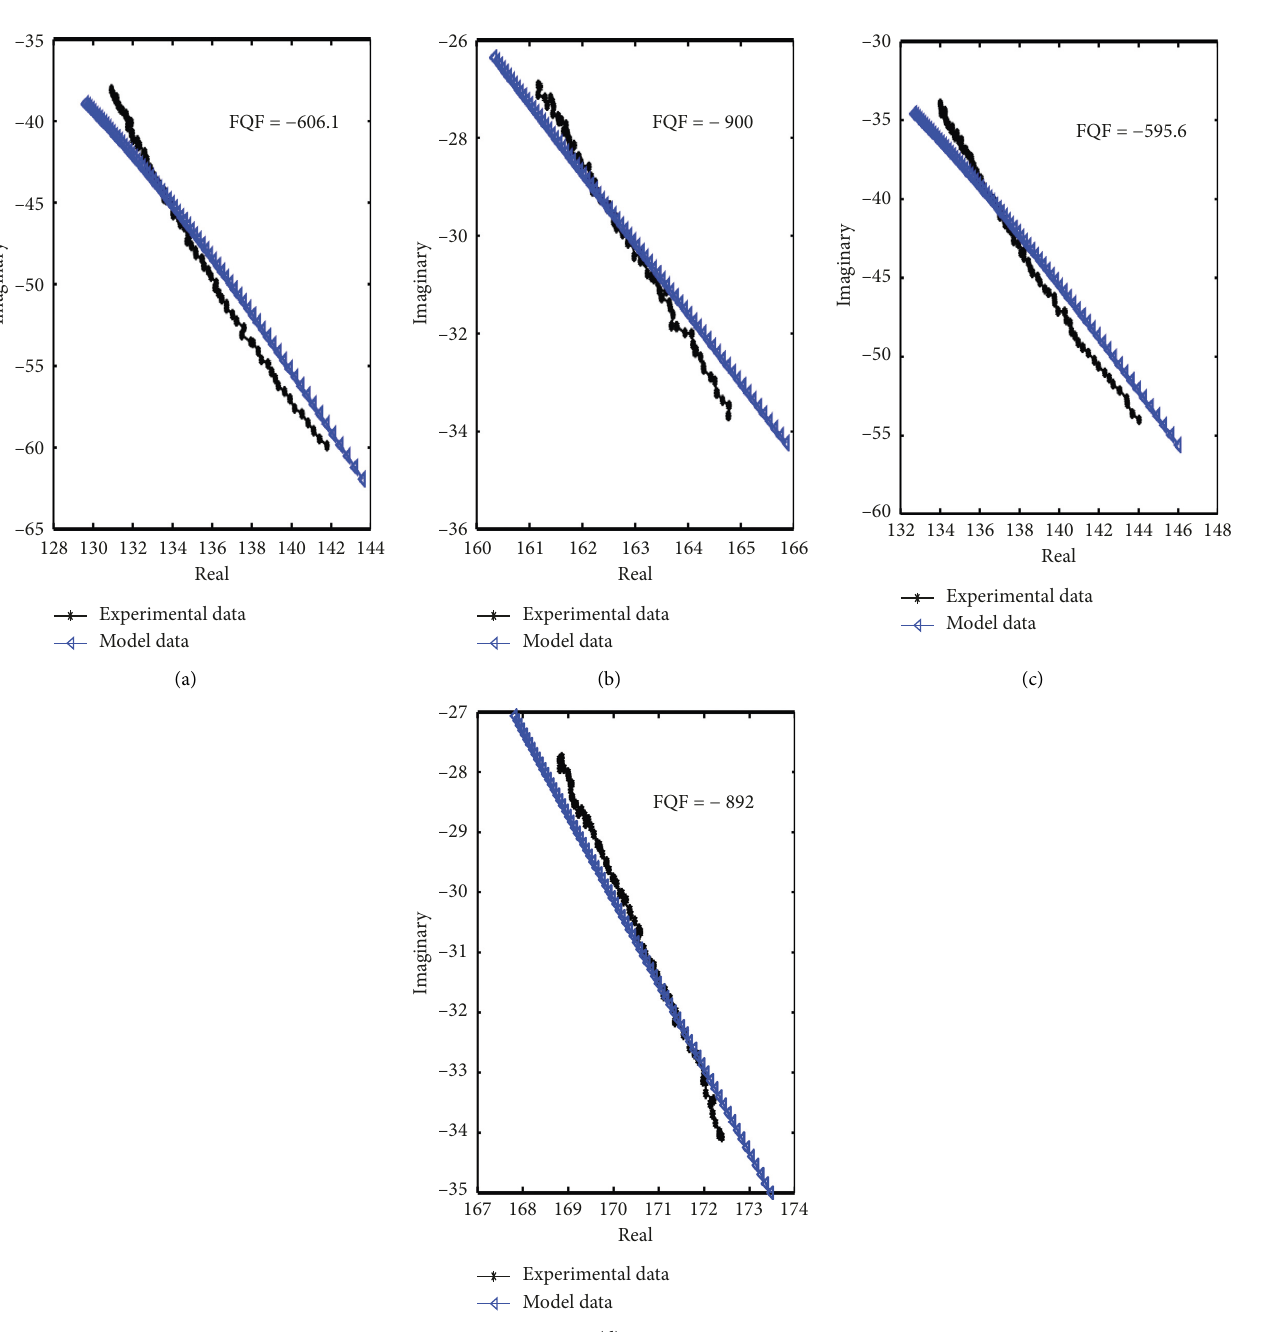
Figure 6 represents the loss rate of the training data set.